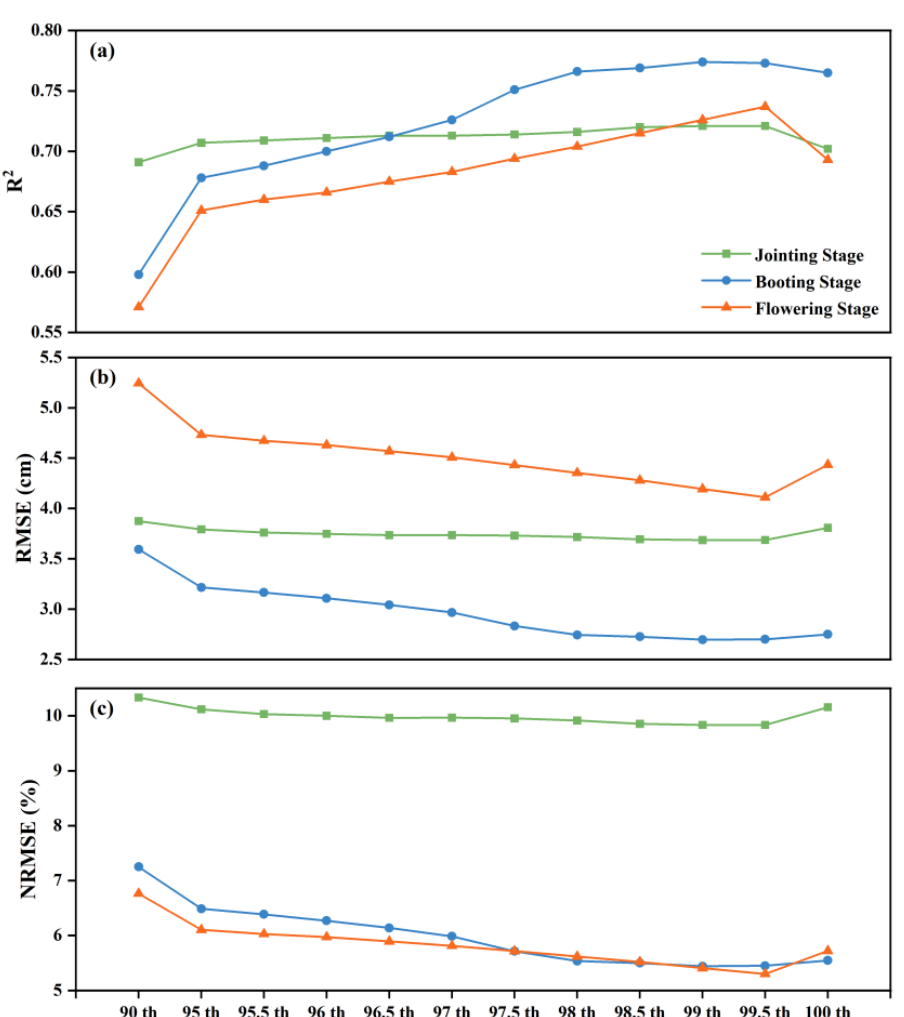
Figure 3. Results of the plant height estimation based on elevation data using the cumulative percentile method. Note: ( a ) coefficient of determination, ( b ) root mean square error, ( c ) normalized root mean square error.